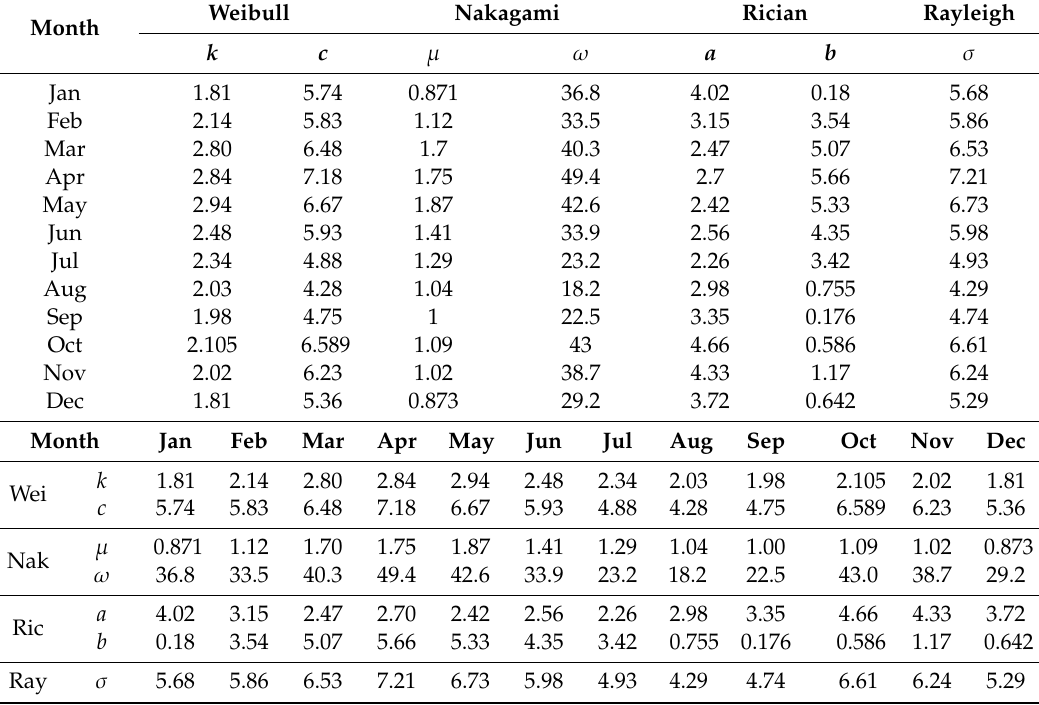
Table 7. Parameters of corresponding distributions based on monthly observed wind